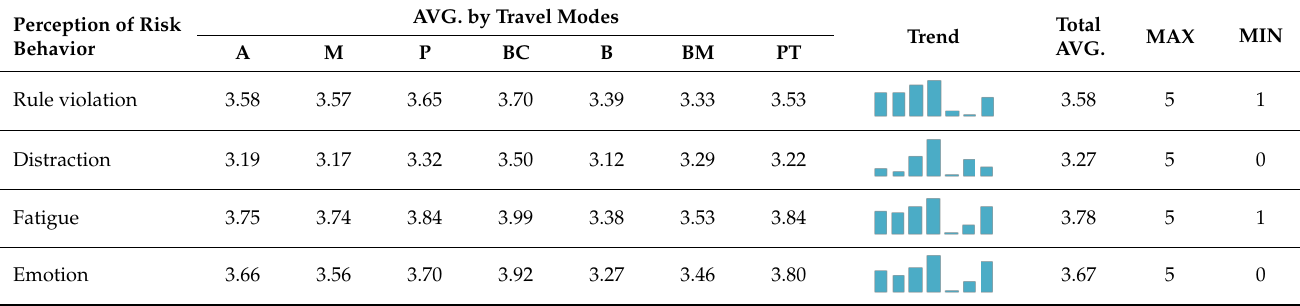
Table 3. Overall data on the perception of risk behaviors and travel modes.